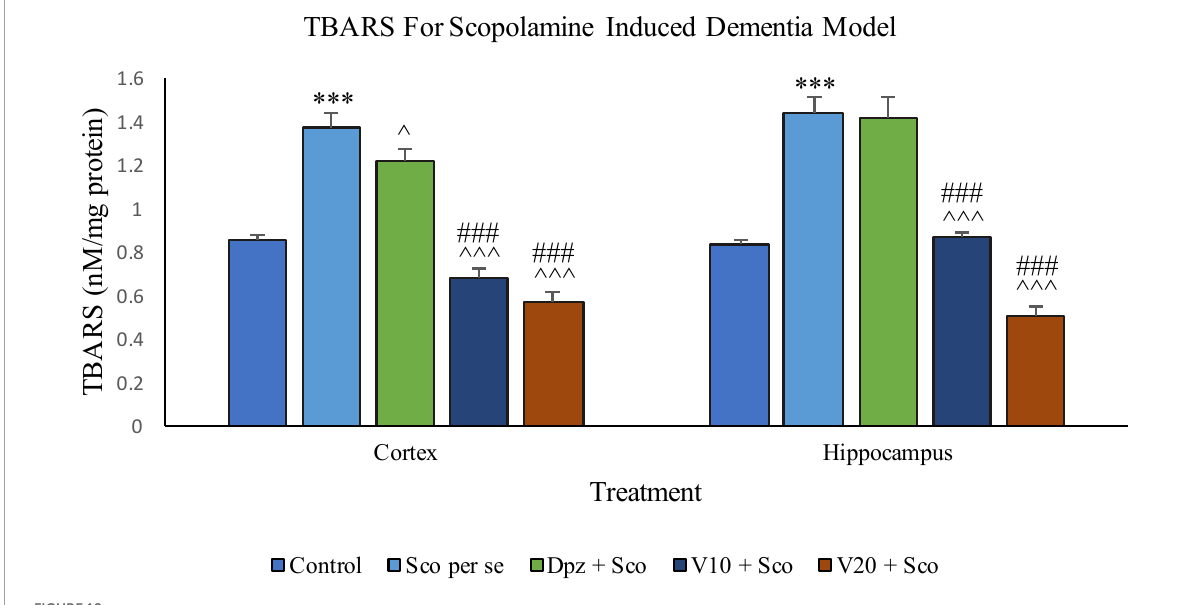
FIGURE18 Effect of vanillin and other treatments on TBARS. Data are expressed as mean ± SEM. “***” denotes P < 0.001 with respect to the control group. “###” denotes P < 0.001 with respect to the standard treatment group. “ ∧∧∧ ” denotes P < 0.001 with respect to the negative control group (Sco per se ), and “ ∧ ” denotes P < 0.05 with respect to the negative control group.